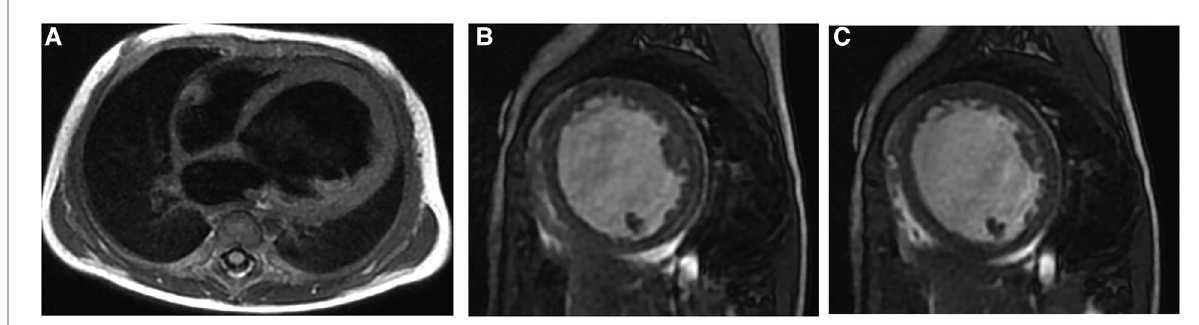
FIGURE 2 Representative MRI scans of a 5-month female EFE patient who presented with cyanosis and shortness of breath. ( A ) Four-chamber D-IR FSE showing LV globular enlargement; the ventricular septum is obviously protruding to the right ventricular side. ( B,C ) Short-axis FIESTA cine at the end of systole and diastole, respectively, showing thickened endocardium and reduced movement of the LV. EFE, endocardial fi broelastosis; LV, left